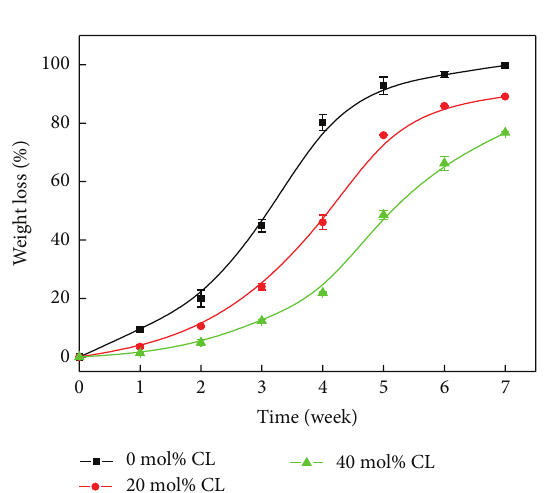
Figure 4: The stress-strain curves of the PLGC copolymers.